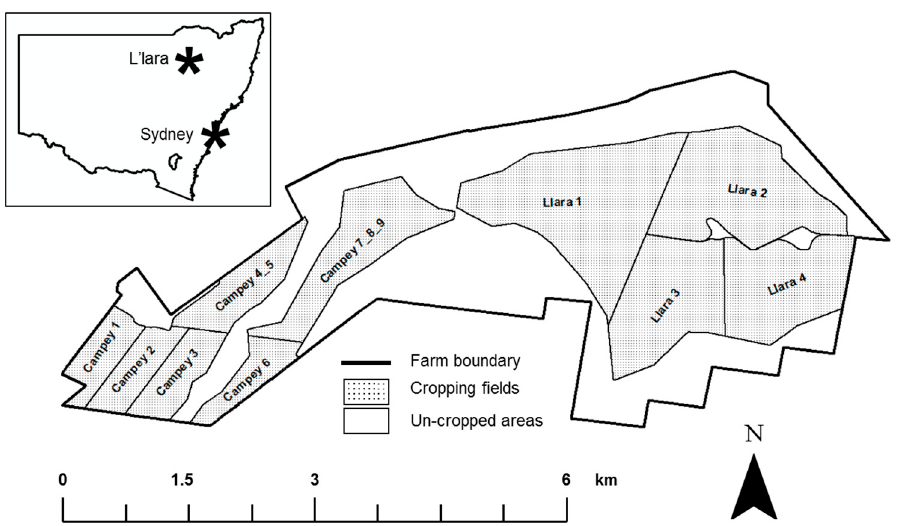
Figure 1. The arrangement of the cropping fields at L’lara, and the location within northern New South Wales (NSW), Australia.